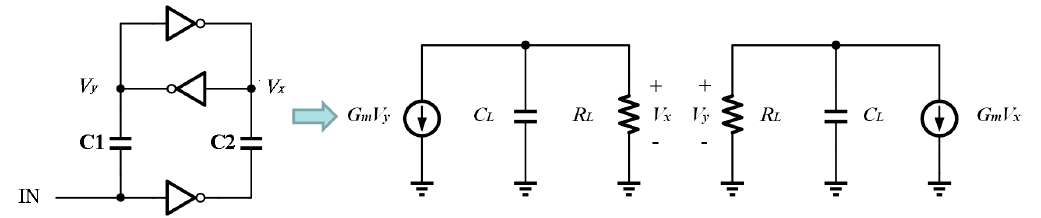
Figure 12. Simplified modeling of the floating level-shifter.